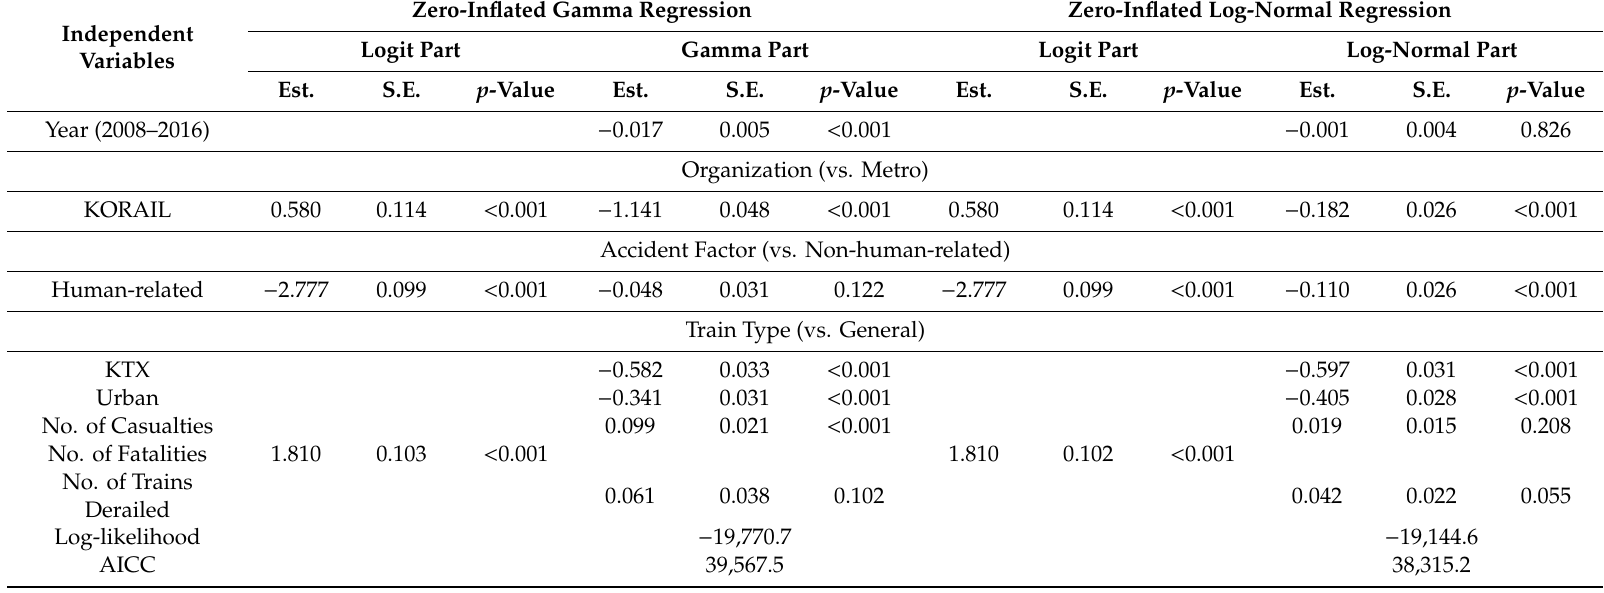
Table 5. Two-Part Regression Analyses of Delay Time (Minute) due to Railway